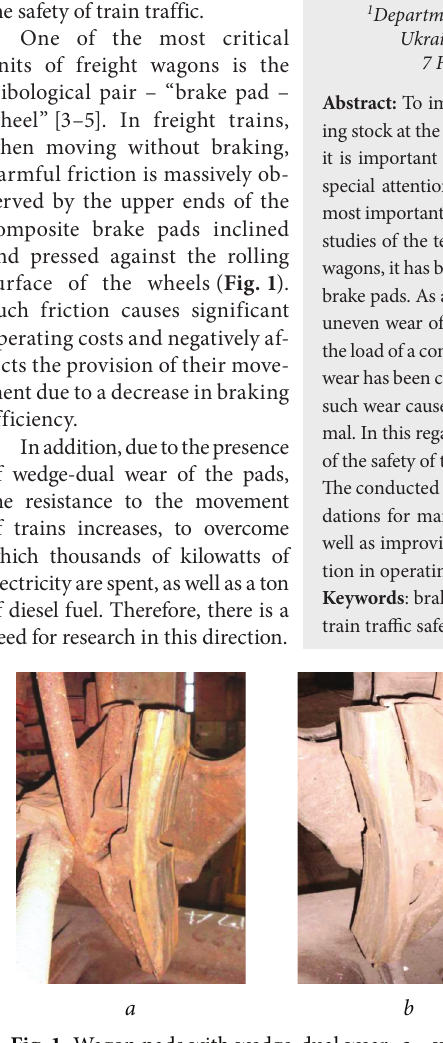
Fig. 1. Wagon pads with wedge-dual wear: a – view from the side of the wheel (left pad); b – view from the side of the wheel (right